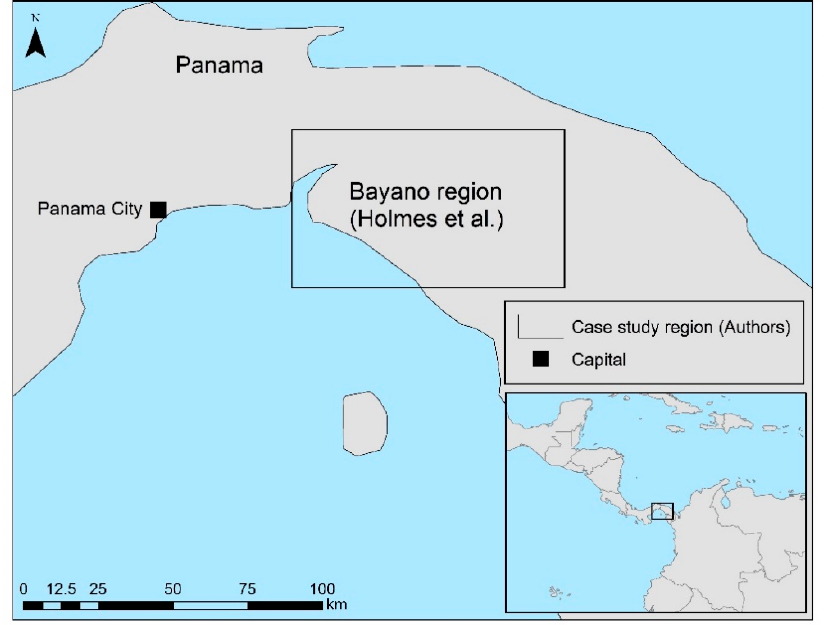
Figure 4. Location of case study in Panama (Syed Zulfiqar Ali Shah for the authors, based on Holmes [31] ).